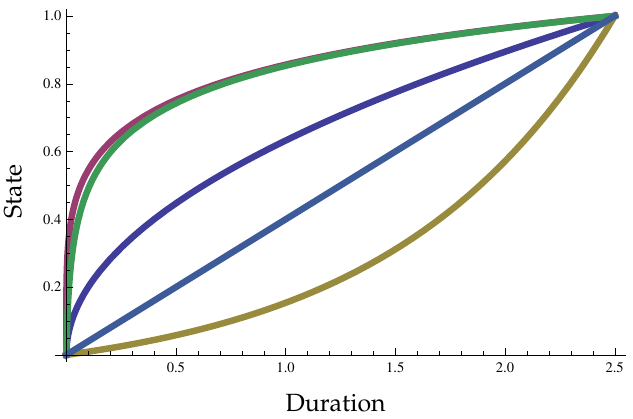
Figure 6. Exp ( 1, r ) (Brown), Linear (Blue), Strategy OFF (Dark Blue), Logarithmic ( 200, r ) (Green), ( r ) (Violet) strategy curves. Progressive 0.312,0.1